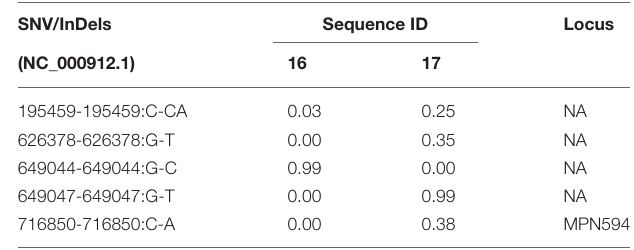
TABLE 3 | Variant frequencies of strains HAP157 and HAP157FUP. SNV/InDels